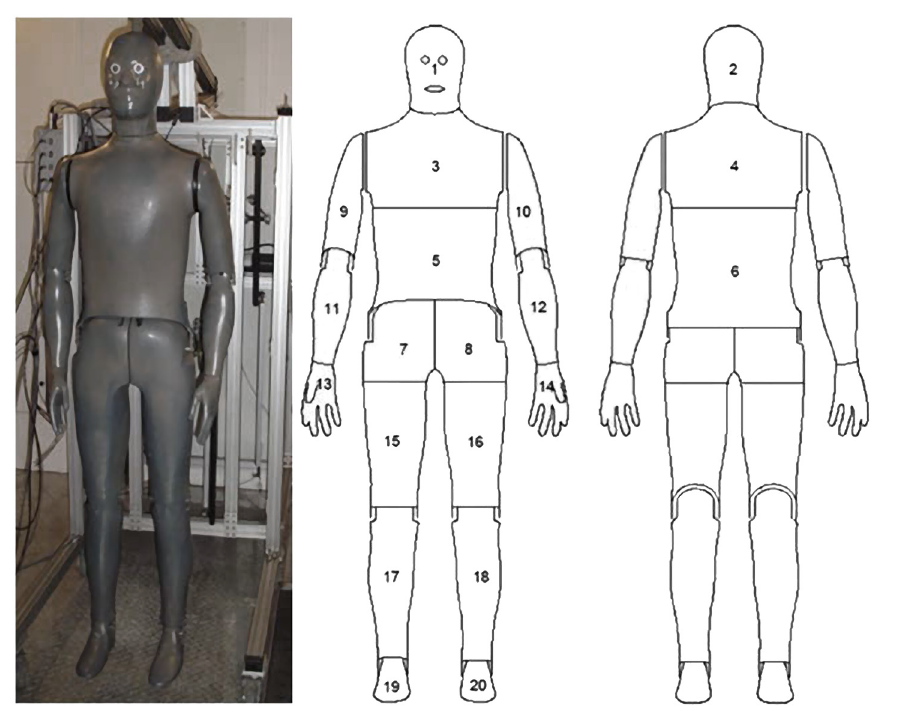
Fig 1. Twenty zone thermal sweating manikin ( “ Newton ” , Measurement Technologies Northwest, Seattle, WA), operated in a climate controlled wind tunnel to derive thermal and evaporative